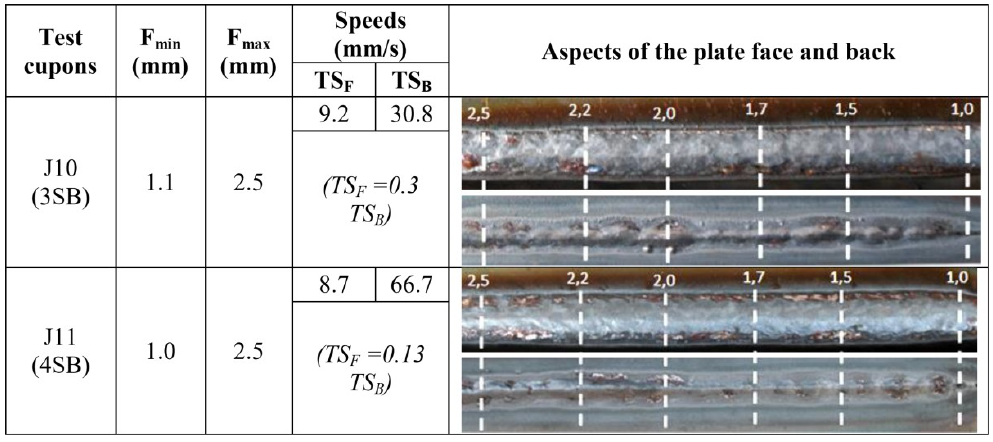
Figure 6. Quantification of the operational gap range for experiments 3SB and 4SB (switchback torch movement), where TS F ˂ TS B .